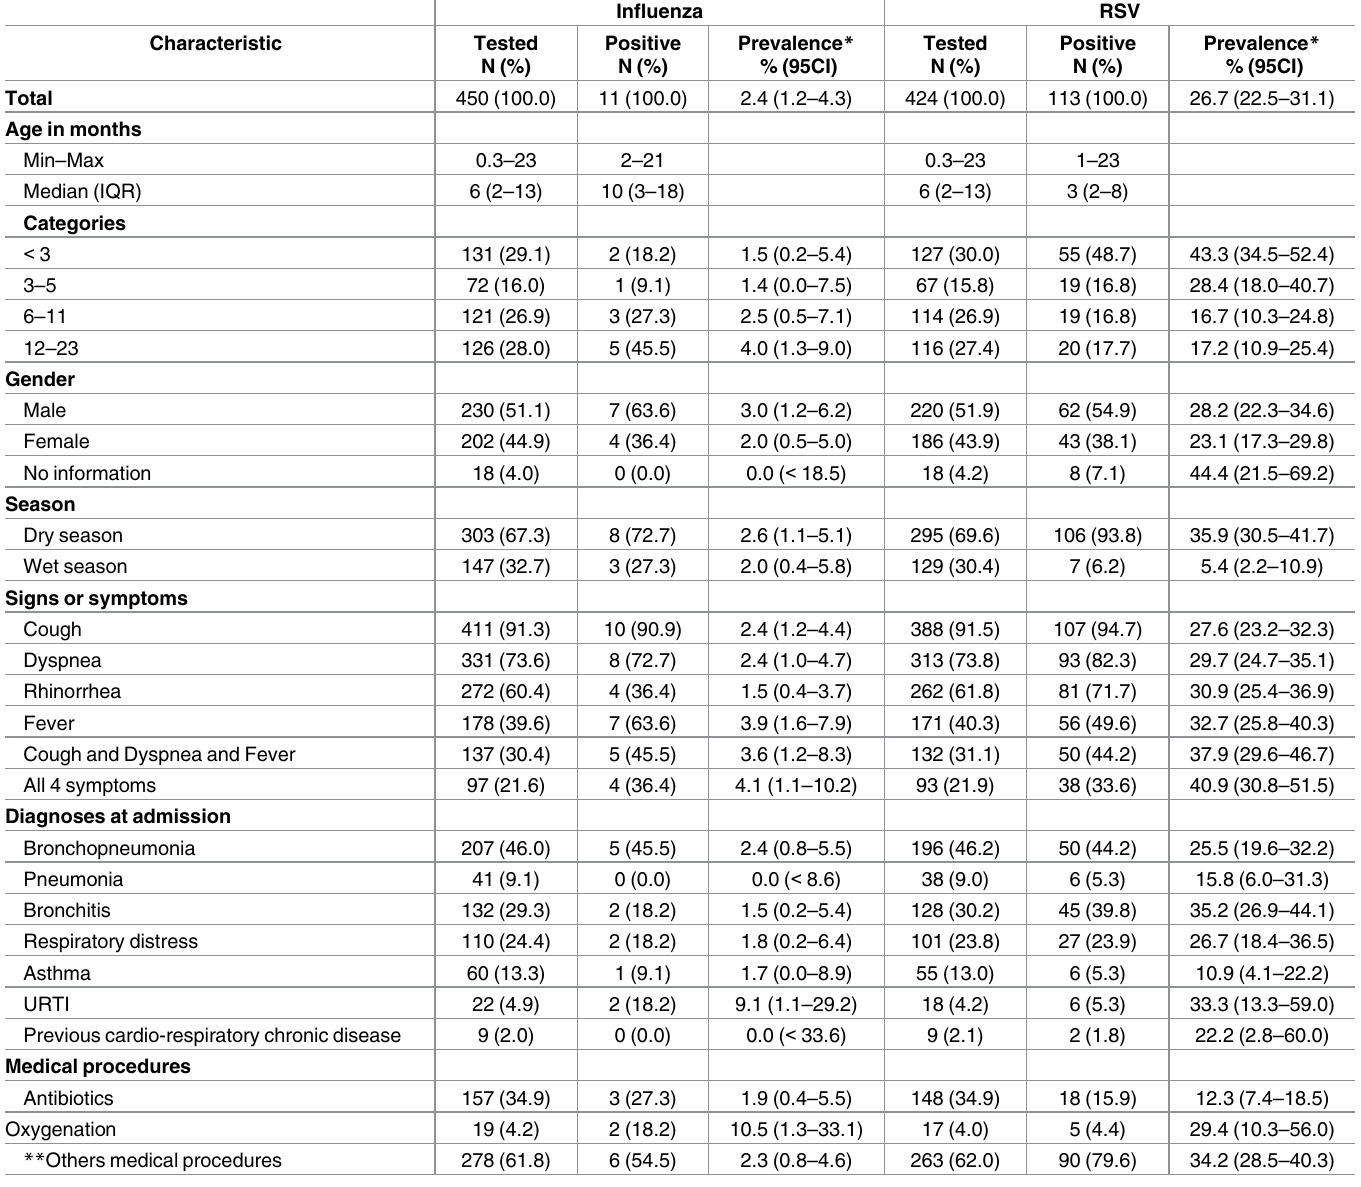
Table 1. Clinical and demographic characteristics of